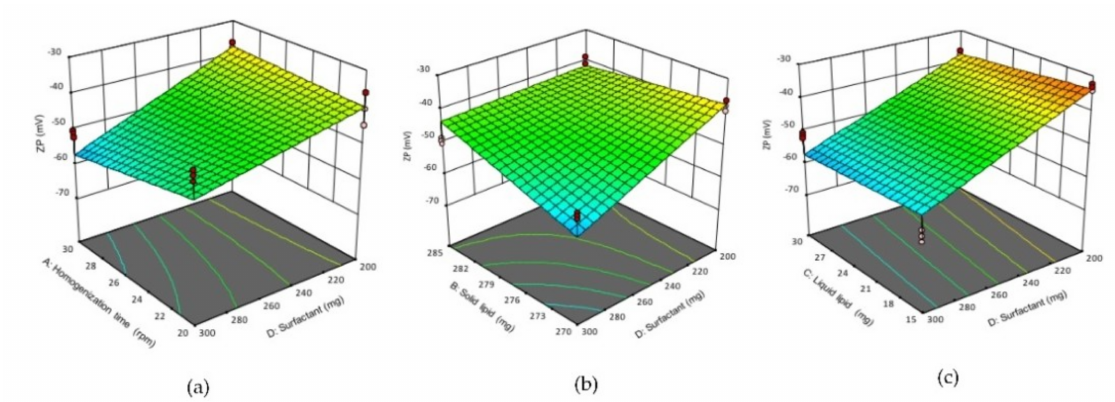
Figure 3. 3D response surface plots showing the effect of interactions ( a ) AD, ( b ) BD ( c ), DC on ZP of NLCs. ( A ) homogenization time, ( B ) solid lipid concentration, ( C ) liquid lipid concentration, ( D ) surfactant concentration.